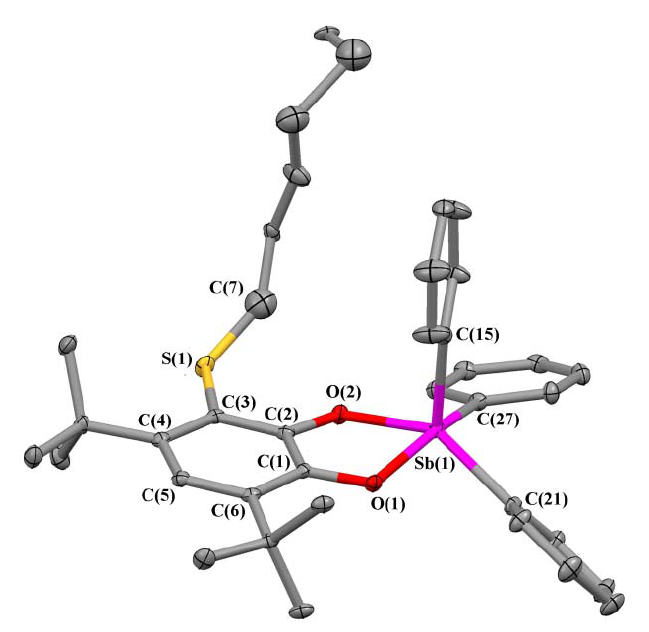
Figure 2. The X ‐ ray structure of (3 ‐ HexS ‐ 4,6 ‐ Cat)SbPh 3 ( 2 ). Hydrogen atoms are omitted, ellipsoids of 30% probability.